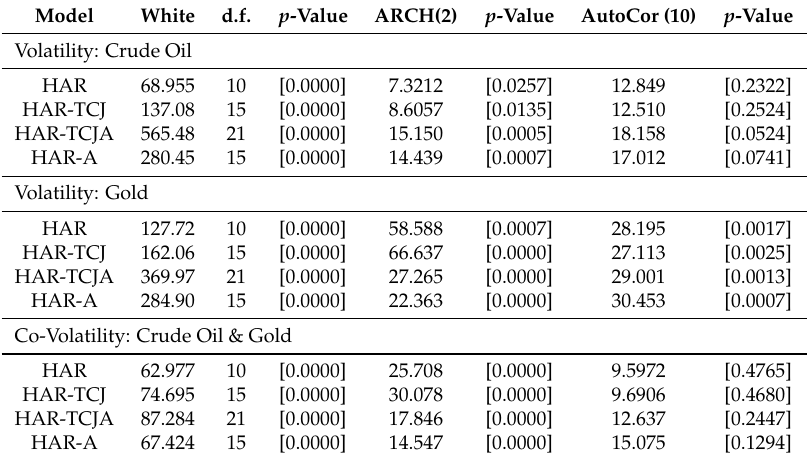
Table 3. Diagnostic tests for daily